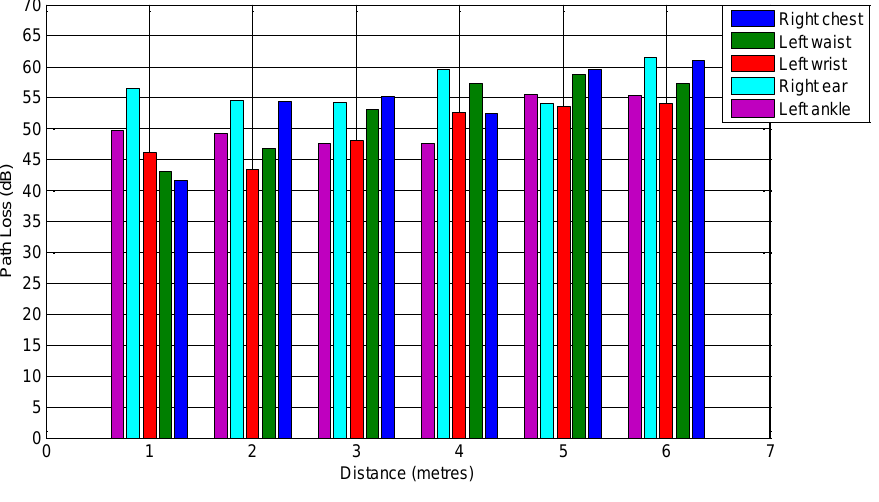
Figure 16. Comparison of path loss for five different off-body channels at 1.9 GHz measured using dual band PIFA, when subject was standing still at 1–6 m locations in sensor